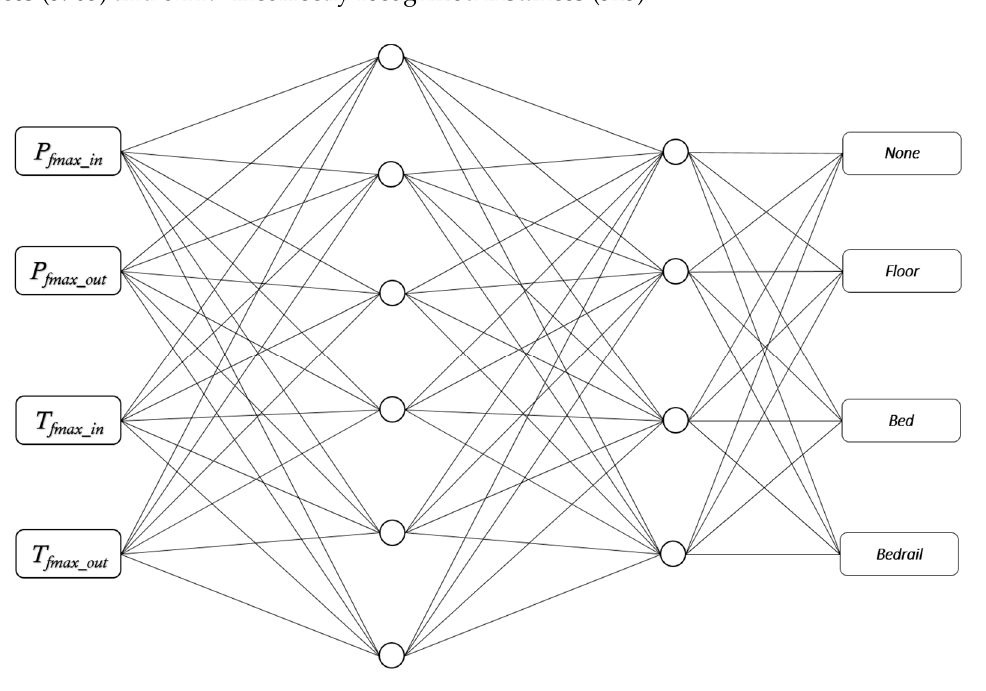
Figure 6. Multilayer Perceptron (MLP) representation with two hidden layers for recognizing location ( L f ).